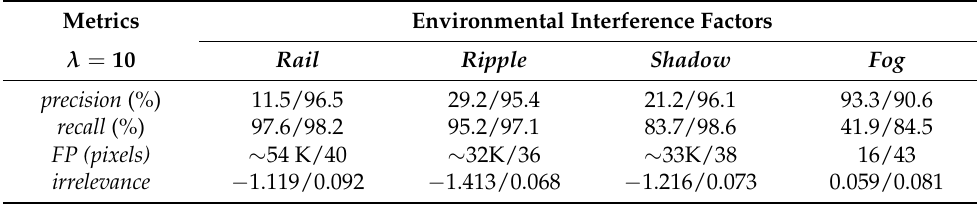
Table 5. Quantitative comparisons of assessed metrics corresponding to the results by edge detection method (left of /) and ours (right of /) under different